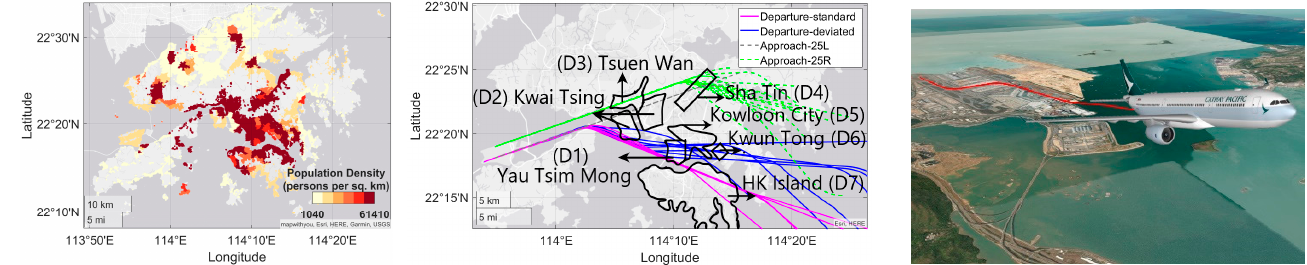
Figure 8. Noise impact by aircraft operation around Hong Kong. Left: Distribution of Hong Kong’s population (2020 year). Center: flightpaths of aircraft flying from/to HKIA whereas passing over densely populated districts in Hong Kong (D1 to D7). Right: A330 aircraft departing from HKIA following a standard departure route.